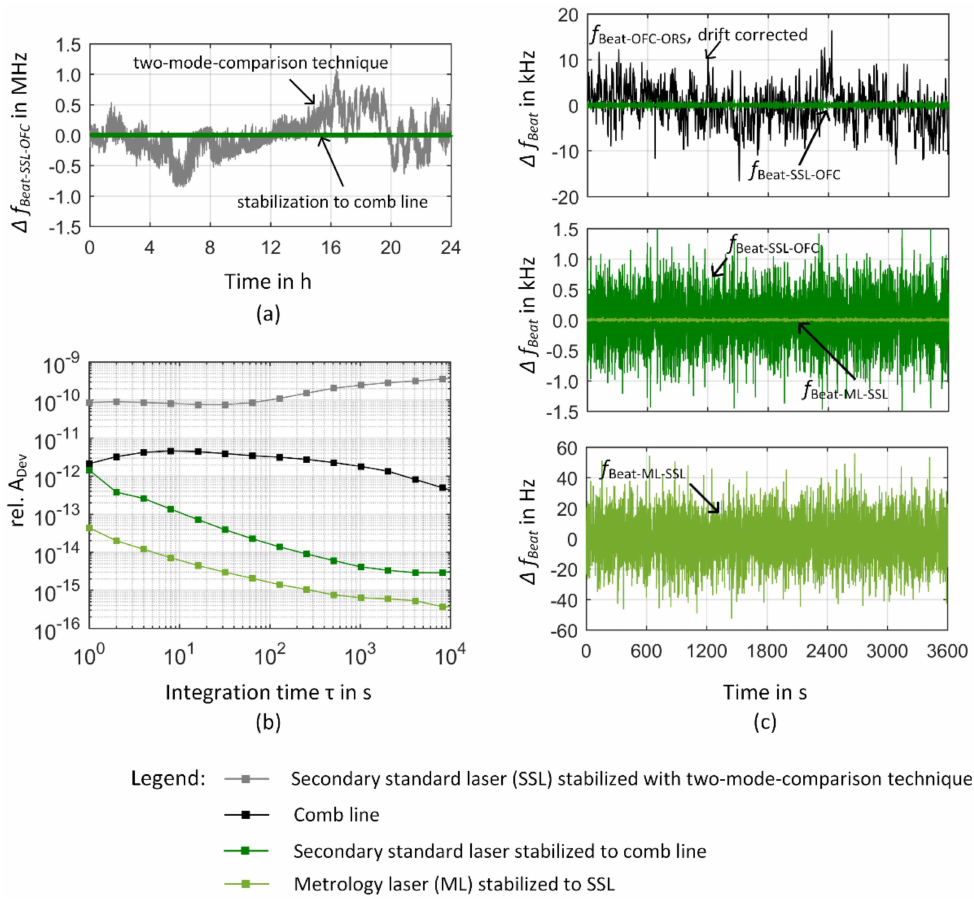
Figure 11. Frequency instability of the comb-referenced-He-Ne heterodyne source. ( a ) 24-h measure- ment series of the secondary standard laser (SSL) prior and after closing the control loop (closed-loop operation reproduced from [35]). ( b ) Relative Allan deviations. The Allan deviation of the OFC is obtained by combining the Allan deviation as calculated from the measurement of the beat signal between the ORS and the OFC for integration times below 4000 s and the Allan deviation given by the manufacturer for integration times above 4000 s. ( c ) The 1 h measurement sections of the 24-h timetrace. The upper graph depicts the SSL locked to the comb and the frequency fluctuations of the drift-removed beat signal between a comb line and the ORS (taken from Figure 9b) for com- parison. Please note that in contrast to the in-loop measurements of the heterodyne source, those measurements were not taken simultaneously. The graph in the middle enlarges the frequency scale to illustrate the frequency fluctuations of the SSL when locked to the comb line. The lower graph further enlarges the frequency scale to depict the fluctuations of the beat signal between the ML and the SSL, when locked to the comb line. All three graphs show the same 1 h section and present the frequency deviations from the respective mean value of the whole measurement